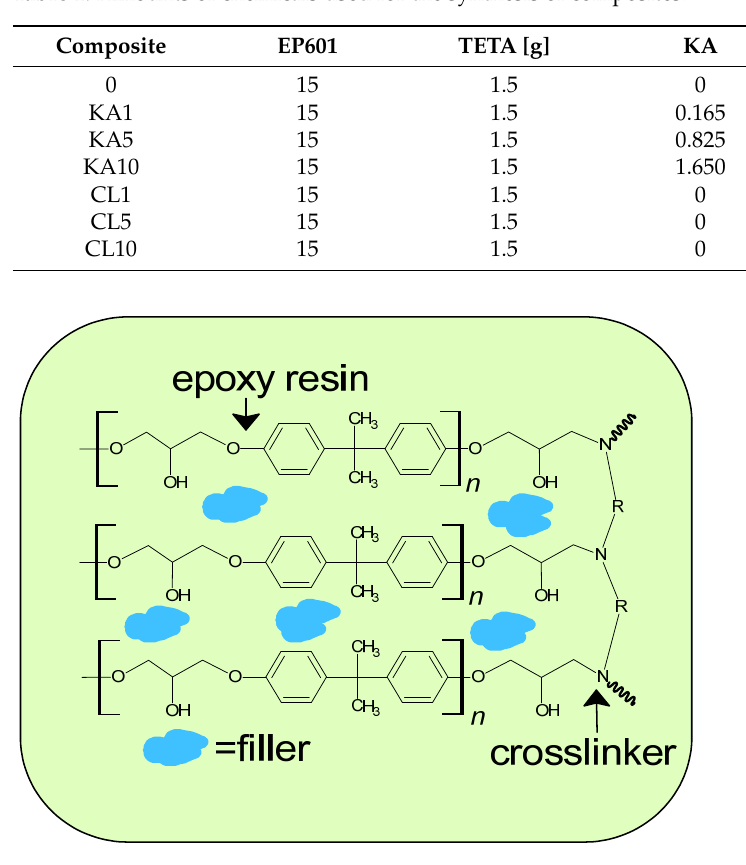
Figure 1. Proposed scheme of composite structure. 104 Table 1. Amounts of chemicals used for the synthesis of composites.